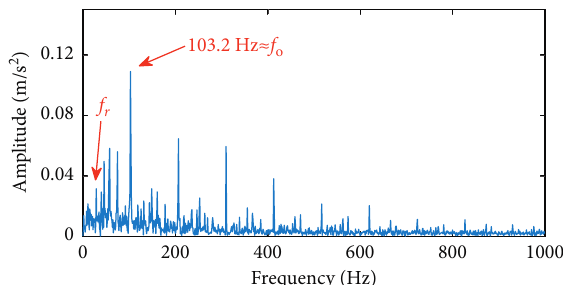
Figure 13: The envelope spectrum for the reconstructed signal of outer ring fault.